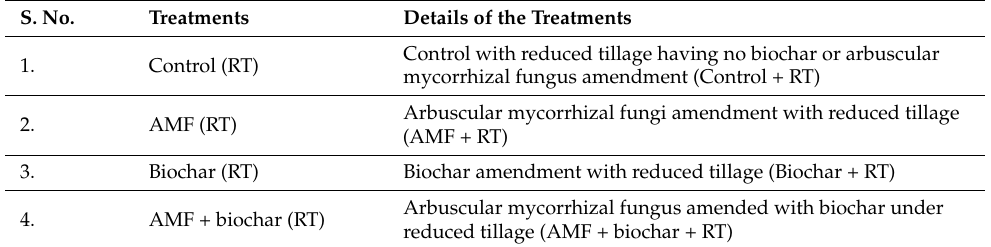
Table 2. Sustainable Agrobiotechnological Interventions Employed in the Present